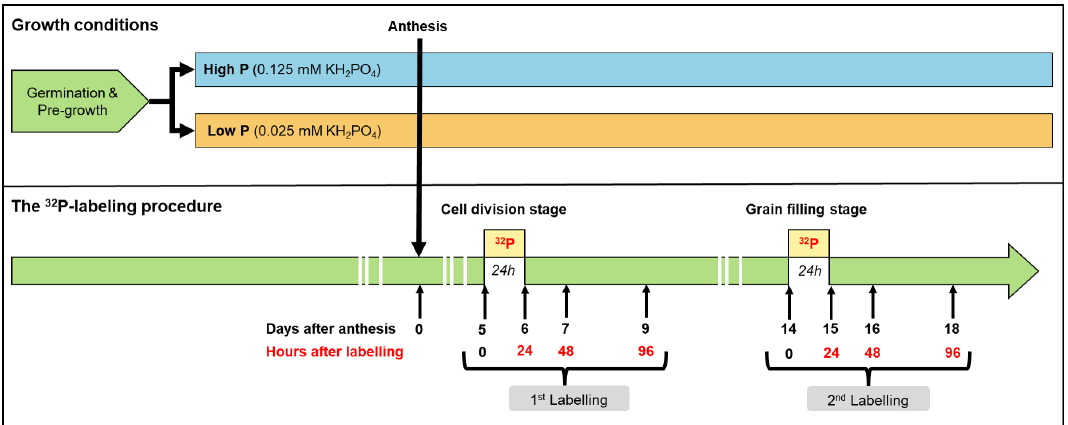
Figure 5. The experimental design used for plant growth and 32 P labeling. Durum wheat plants were grown hydroponically under high and low P supplies under greenhouse conditions. The 32 P labeling experiments were performed at 5 and 14 days after anthesis and lasted for 24 h. For labeling, plants were harvested after 24, 48, and 96 h after labeling. Three plant replicates were sampled at each harvest